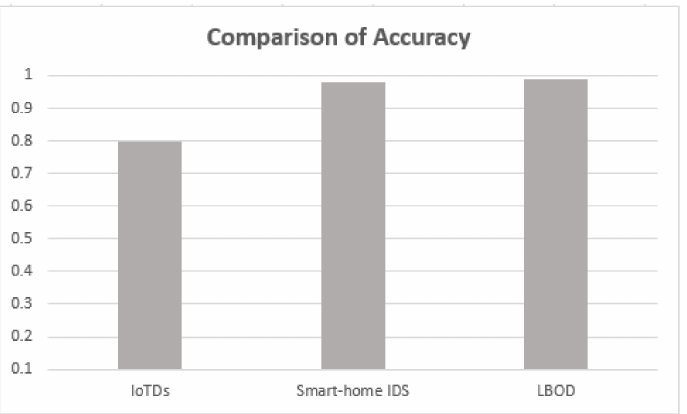
Figure 10. Comparison of accuracy.